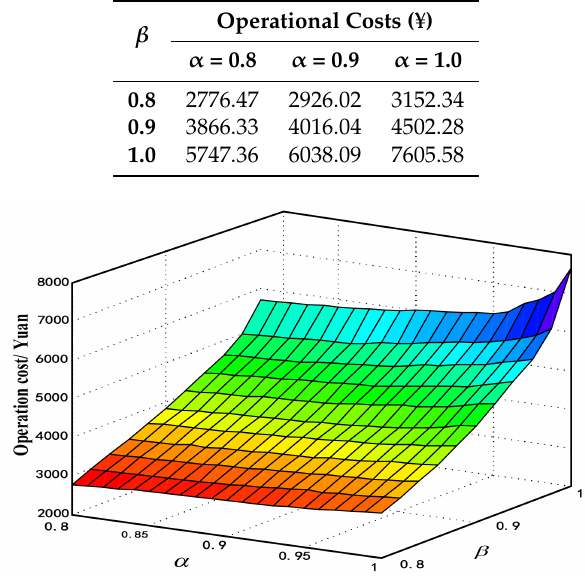
Figure 3. The varied-curve surface diagram of operational cost.